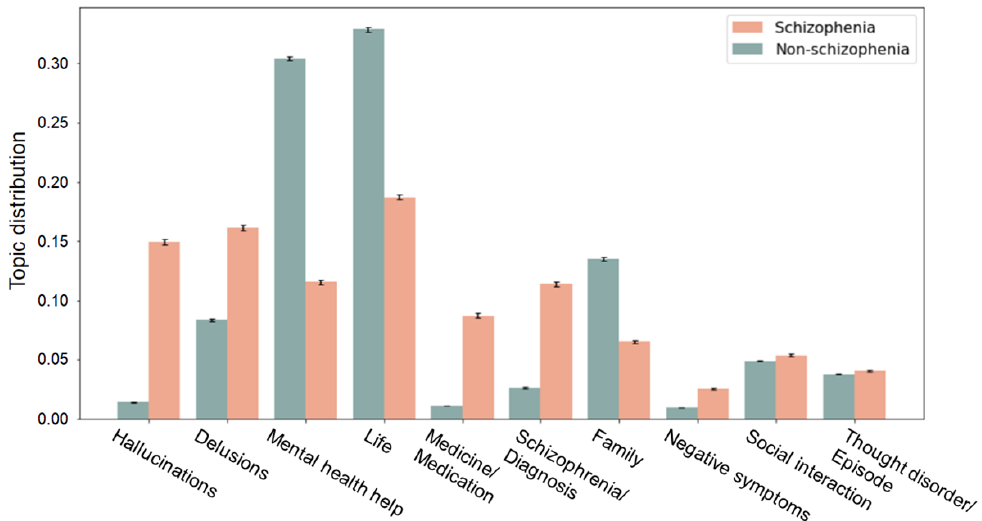
Figure 3. Comparison of the topic distributions between the schizophrenia and the non-schizophrenia (control) groups within topics identified from the schizophrenia posts. Bars and error bars correspond, respectively, to averages and standard deviations across the topic distribution values. All pairwise comparisons show significant differences in topic distributions between the two groups. Schizophrenia has statistically higher topic distributions in “hallucinations”, “delusions”, “negative symptoms”, and “medicine and medication” (all p < 0.001) and lower values in topics of “life” and “family” (all p < 0.001), compared to the control group.